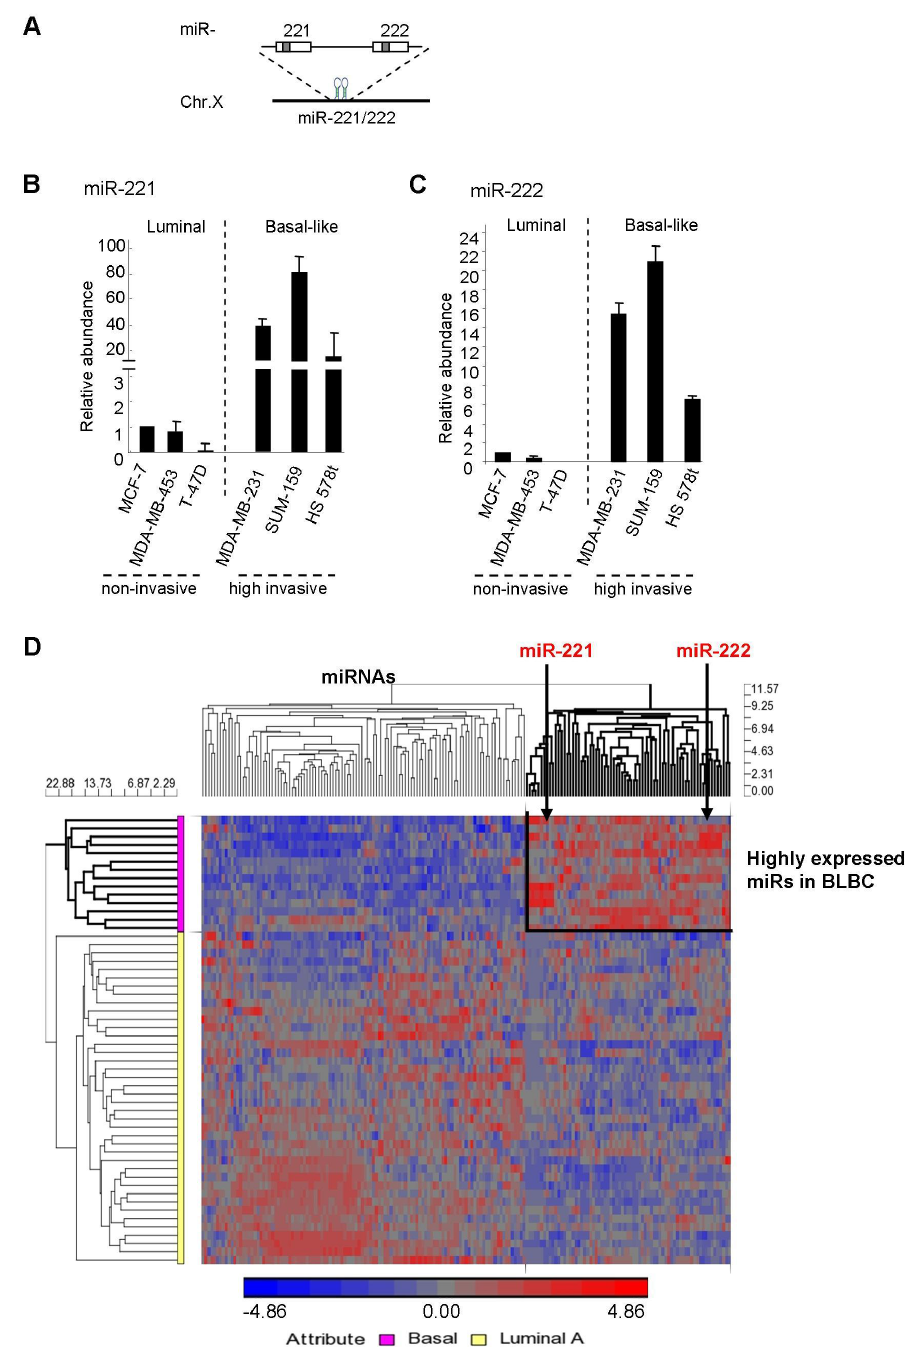
Figure 1. High expression of miR-221/222 in highly invasive BLBC. ( A ) Schematic indication of the miR-221/222 cluster on human chromosome X. ( B , C ) Relative abundance of miR-221 ( B ) and miR-222 ( C ) in highly invasive basal-like subtype (MDA-MB-231, Hs578t and SUM159) and non-invasive luminal subtype (MCF-7, T-47D and MDA-MB-453) breast cancer cell lines. Data are shown as mean ± SEM (SEM was derived from three independent experiments). ( D ) Tree view display of miRNA expression profile from 101 human breast cancer patient samples for luminal A and basal-like genetic subtypes. A subset of miRNAs including miR-221 and miR-222 showed higher expression in Basal than Luminal A subtype of breast